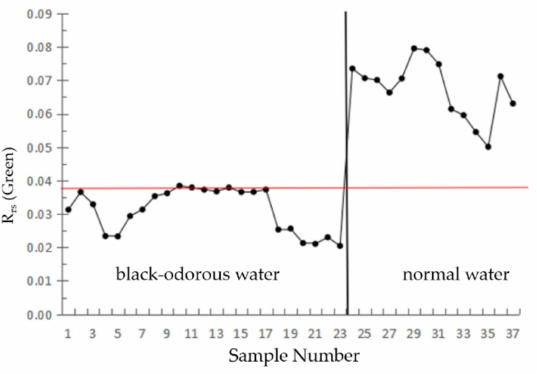
Figure 6. Single-band threshold method.